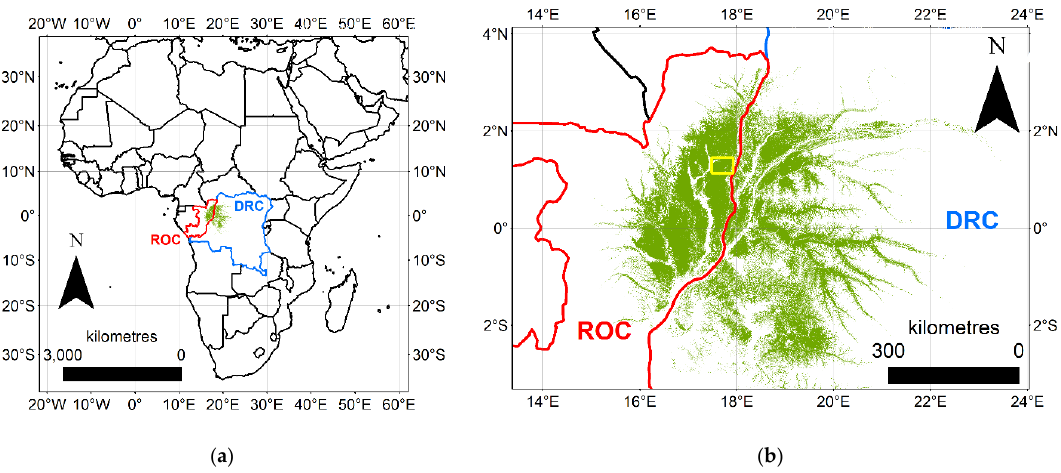
Figure 1. The location of the Centrale Cuvette peat deposit (green) in the Republic of Congo (ROC) and Democratic Republic of Congo (DRC) [5]; ( a ) large scale; ( b ) local scale, field site in yellow.